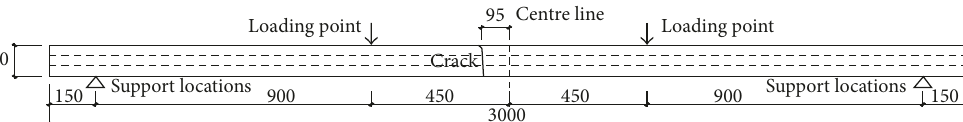
Figure 23: Crack location